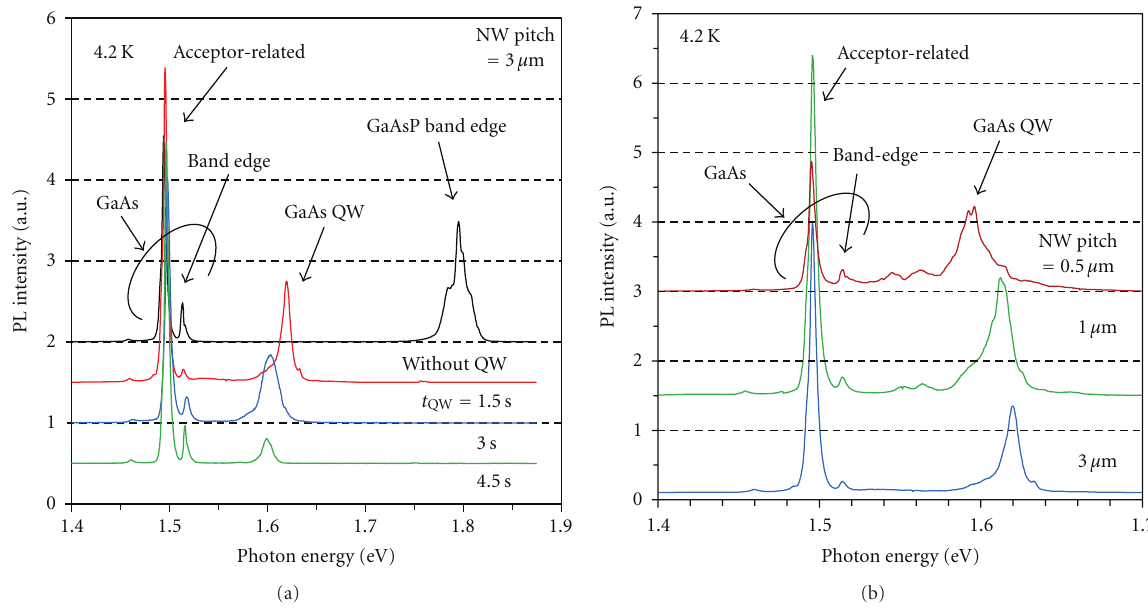
Figure 15: 4.2-K PL spectra for heterostructure NWs with GaAs QW buried in GaAsP. (a) PL spectra for NWs with GaAs QW for growth times ( t QW ) of 1.5, 3.0, and 4.5 sec. NW pitch is 3 μ m. PL spectrum for GaAsP/GaAs heterostructure NW without QW has been plotted as reference. (b) PL spectra for NWs with GaAs QW for NW pitches of 0.5, 1.0, and 3.0 μ m. t QW is 1.5sec.